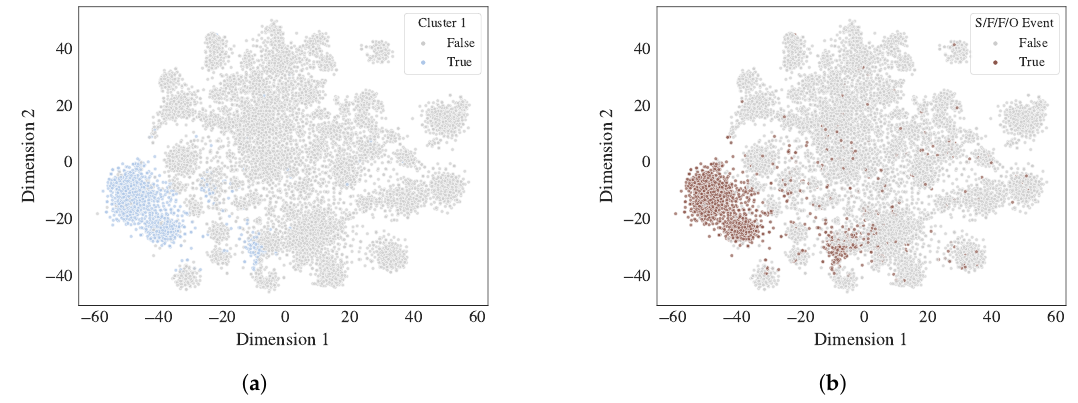
Figure 9. Side-by-side of Cluster 1 and narratives labeled as having a Smoke/Fire/Fumes/Odor Event. ( a ) Highlight of Cluster 1. ( b ) Presence of Smoke/Fire/Fumes/Odor